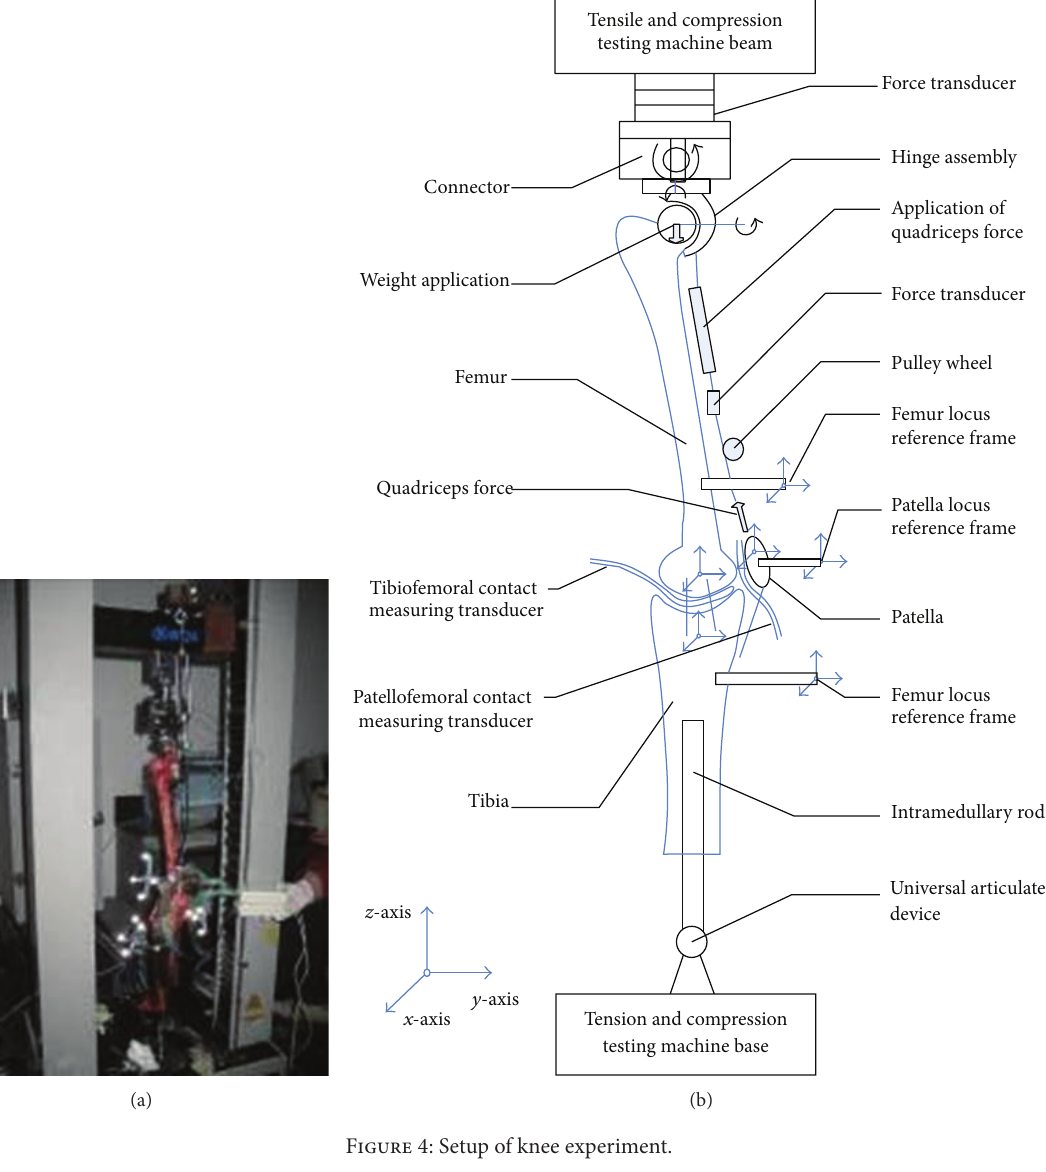
Figure 4: Setup of knee